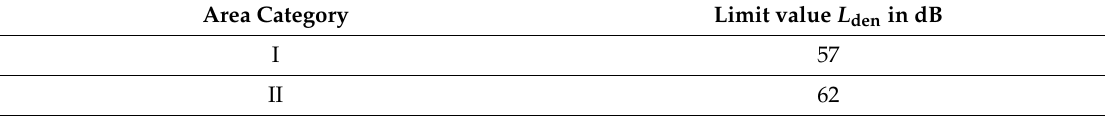
Table 4. Japanese Environmental Quality Standards for Aircraft Noise (revised in